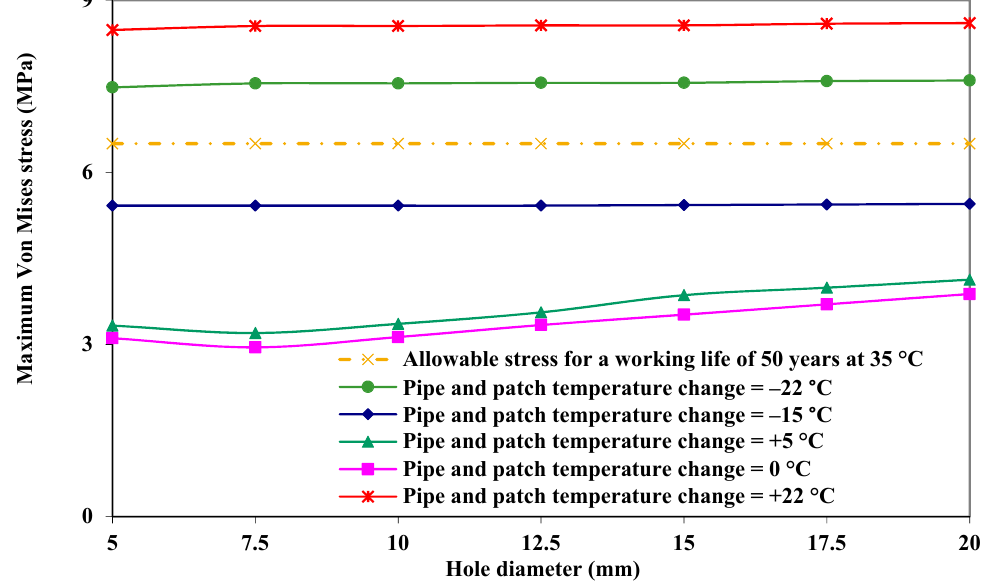
Figure 14. Maximum Von Mises stress in the circular partial patch for various sizes of circular hole defects (the simultaneous effect of mechanical and thermal loads).